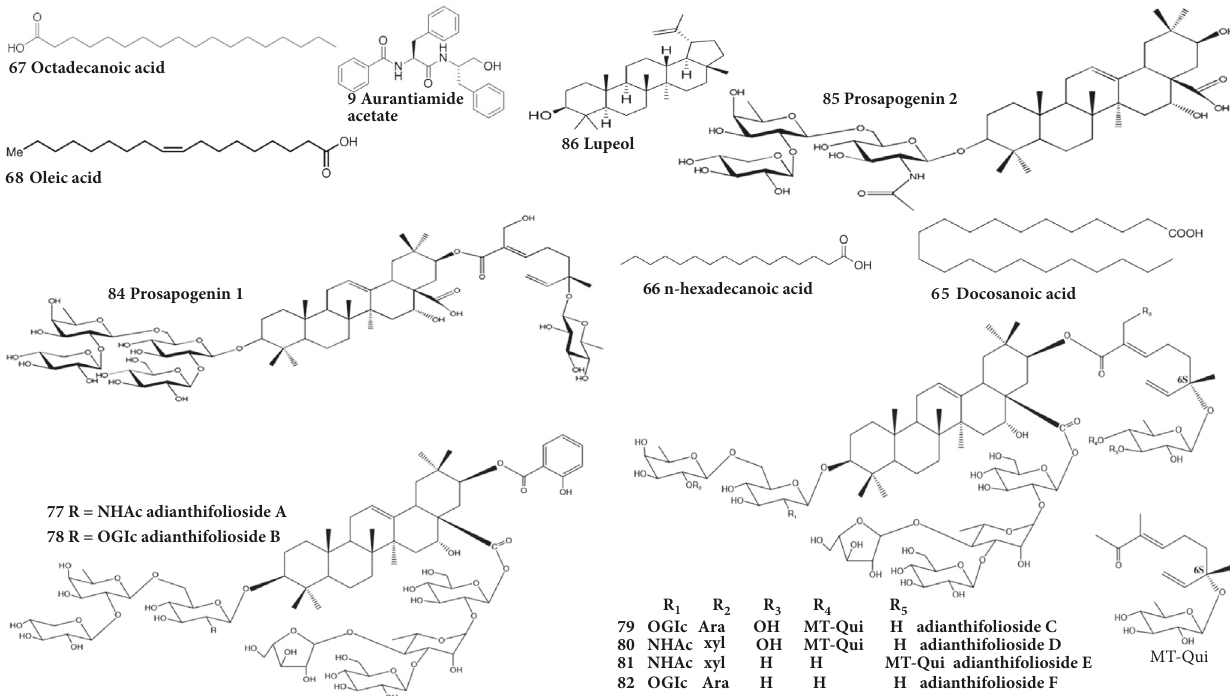
Figure 4: Chemical structures of some compounds isolated from Albizia adianthifolia that exhibited pharmacological activities.